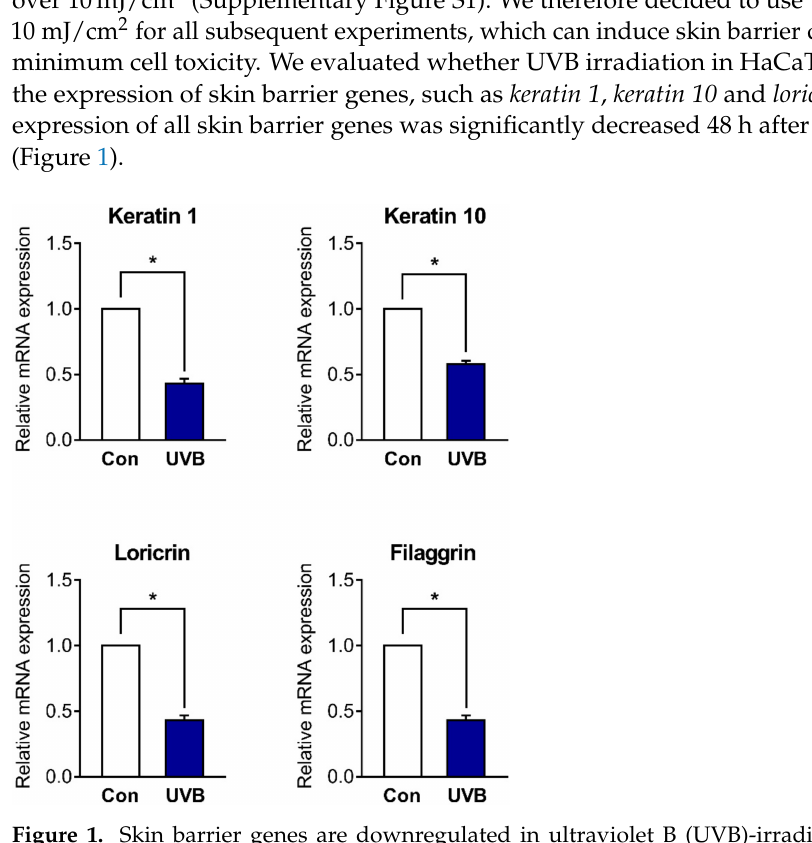
Figure 1. Skin barrier genes are downregulated in ultraviolet B (UVB)-irradiated HaCaT cells. The cells were treated with or without UVB irradiation (10 mJ/cm 2 ) and harvested after 48 h. Then, the relative mRNA expression of skin barrier genes ( keratin 1 , keratin 10 , loricrin, and filaggrin ) was determined. Results are shown as mean ± standard error of the mean (SEM) of three experiments. * p < 0.05, between the